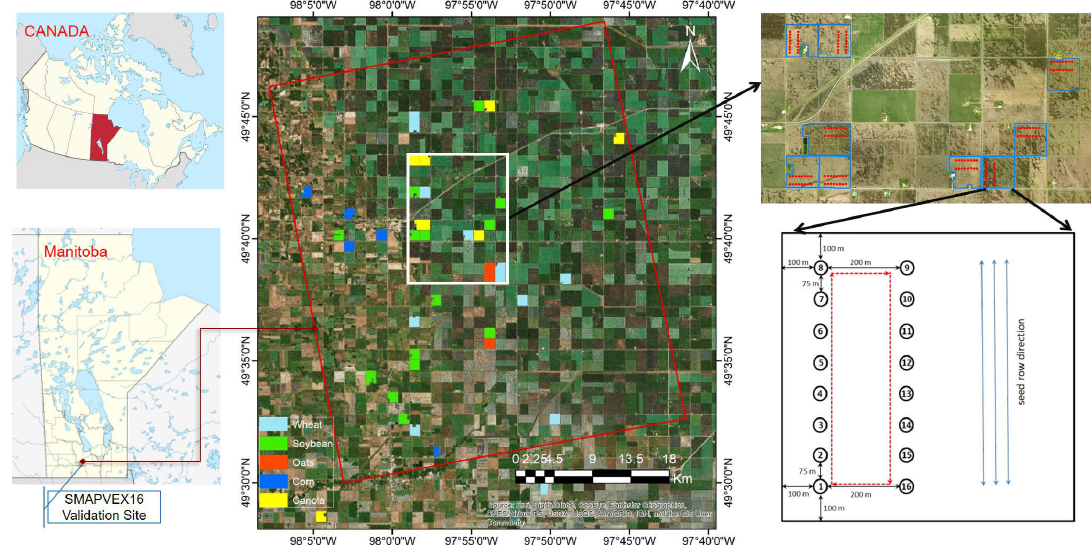
Figure 1. Study area and sampling locations over the JECAM-Manitoba (Canada) test site. The layout of the sampling locations within each field is highlighted for vegetation sampling.